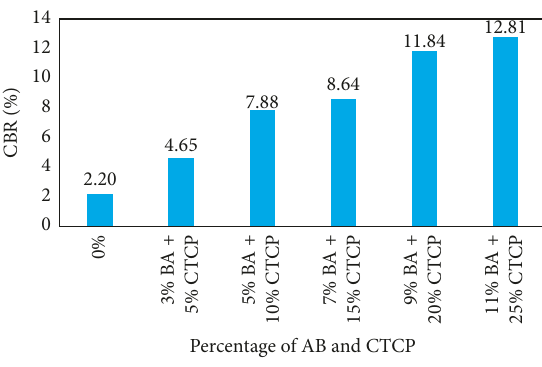
Figure 18: Combined effect of BA and CTCP on CBR.